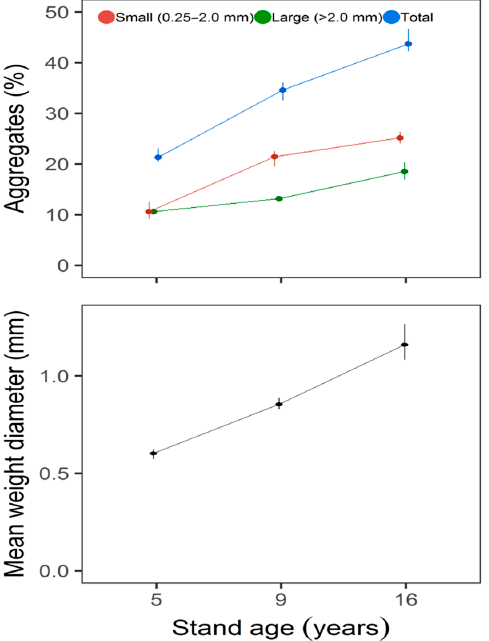
Figure 2. The effects of stand age on the weight percentage and mean weight diameter of soil aggregates in the topsoil (0–10 cm) of poplar plantations ( n = 3). Values are bootstrapped means ± 95% confidence intervals (CIs). Differences between stand ages or size classes are significant at α = 0.05 if their CIs do not overlap the other’s mean. Table 2. The effects of stand age on small, large, and total aggregates, mean weight diameter, soil organic carbon in bulk soil, and organic carbon content in fine and large aggregates ( n = 3).